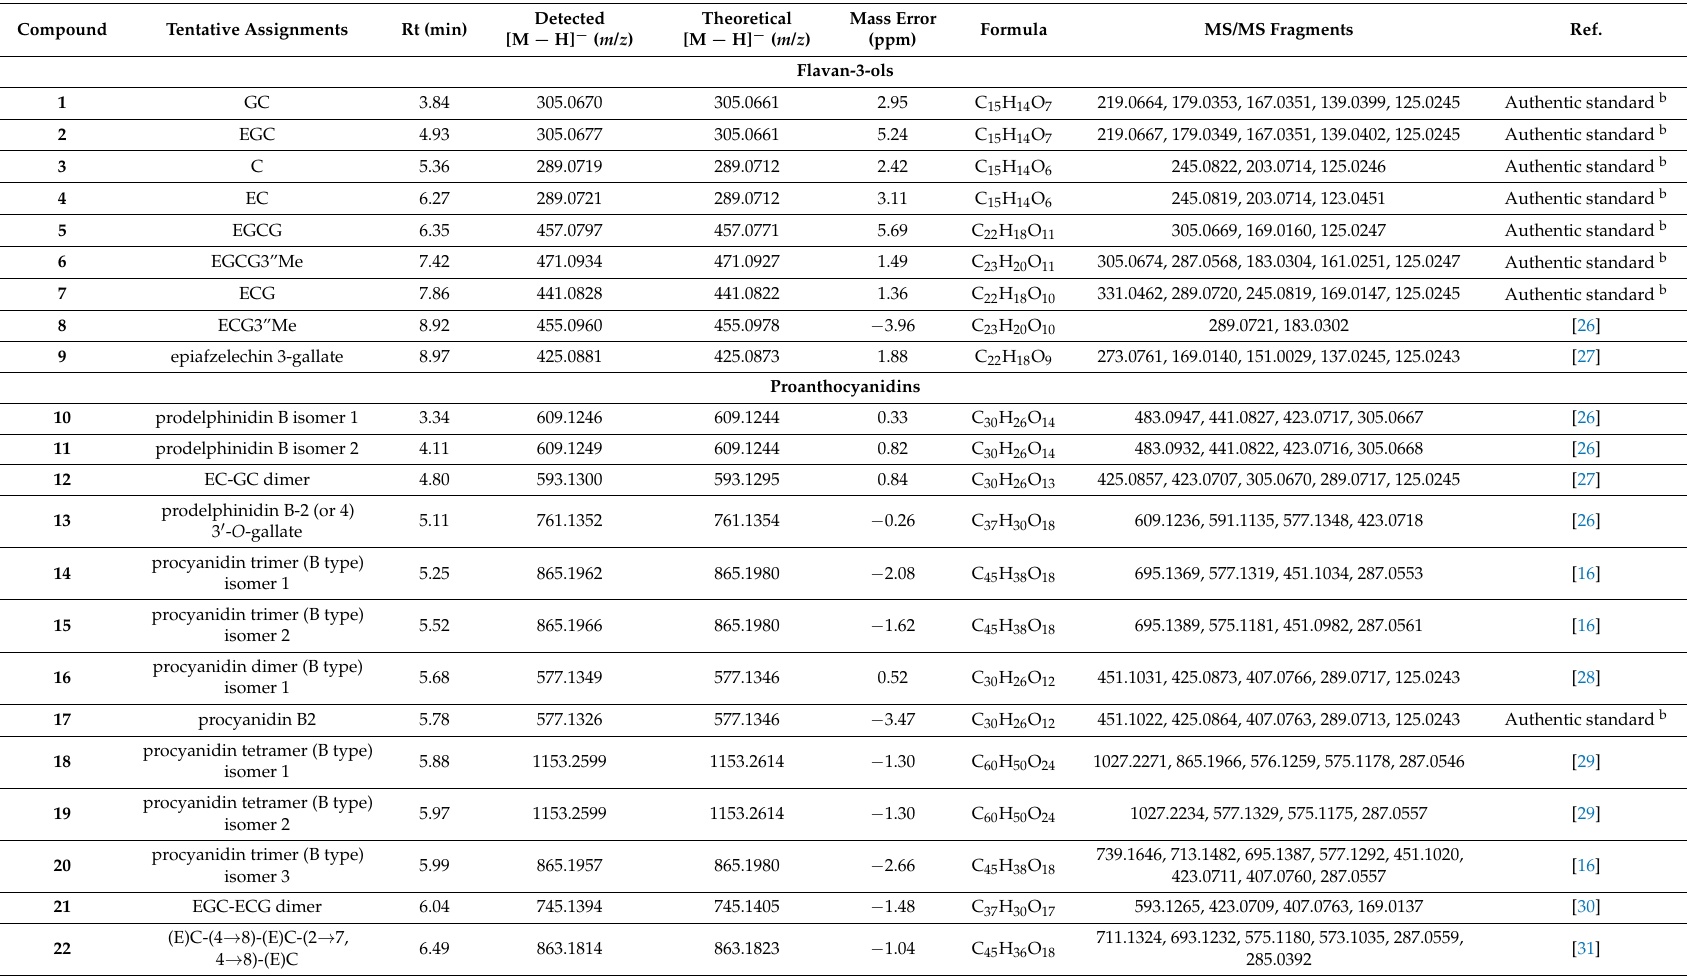
Table 1. Metabolites putatively identified in six tissues of Tieguanyin tea plants by UPLC-QTOF